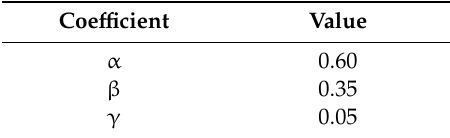
Table 10. Weighting coe ffi cients of the information